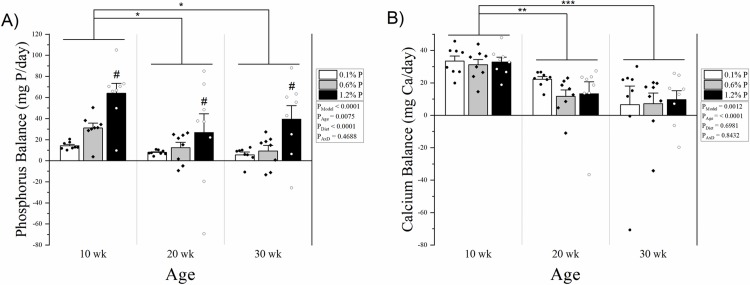
A) Phosphorus balance by age and dietary phosphorus intake level. There was a main effect for age where 10 week old rats had higher phosphorus balance compared to both 20 and 30 week olds, and the high phosphorus diet group was higher than normal and low phosphorus, with no significant age x diet interaction. B) Calcium balance by age and dietary phosphorus intake level. There was a main effect for age where 10 week old rats had higher calcium balance compared to both 20 and 30 week olds, but there was no significant effect of dietary phosphorus intake level and no significant age x diet interaction. Balance for each mineral was calculated as intake–fecal + urine. Means and standard error bars are shown for each group. Low phosphorus diet (0.1%) is shown in white bars and black dots; normal phosphorus diet (0.6%) is shown in grey with black diamonds; and high phosphorus diet (1.2%) is shown in black with white circles. ANOVA p-values for the overall model (PModel), main effect of age (PAge), main effect of diet (PDiet), and interaction of age and diet (PAxD) are shown. * p < 0.05, ** p < 0.01, *** p < 0.0001.